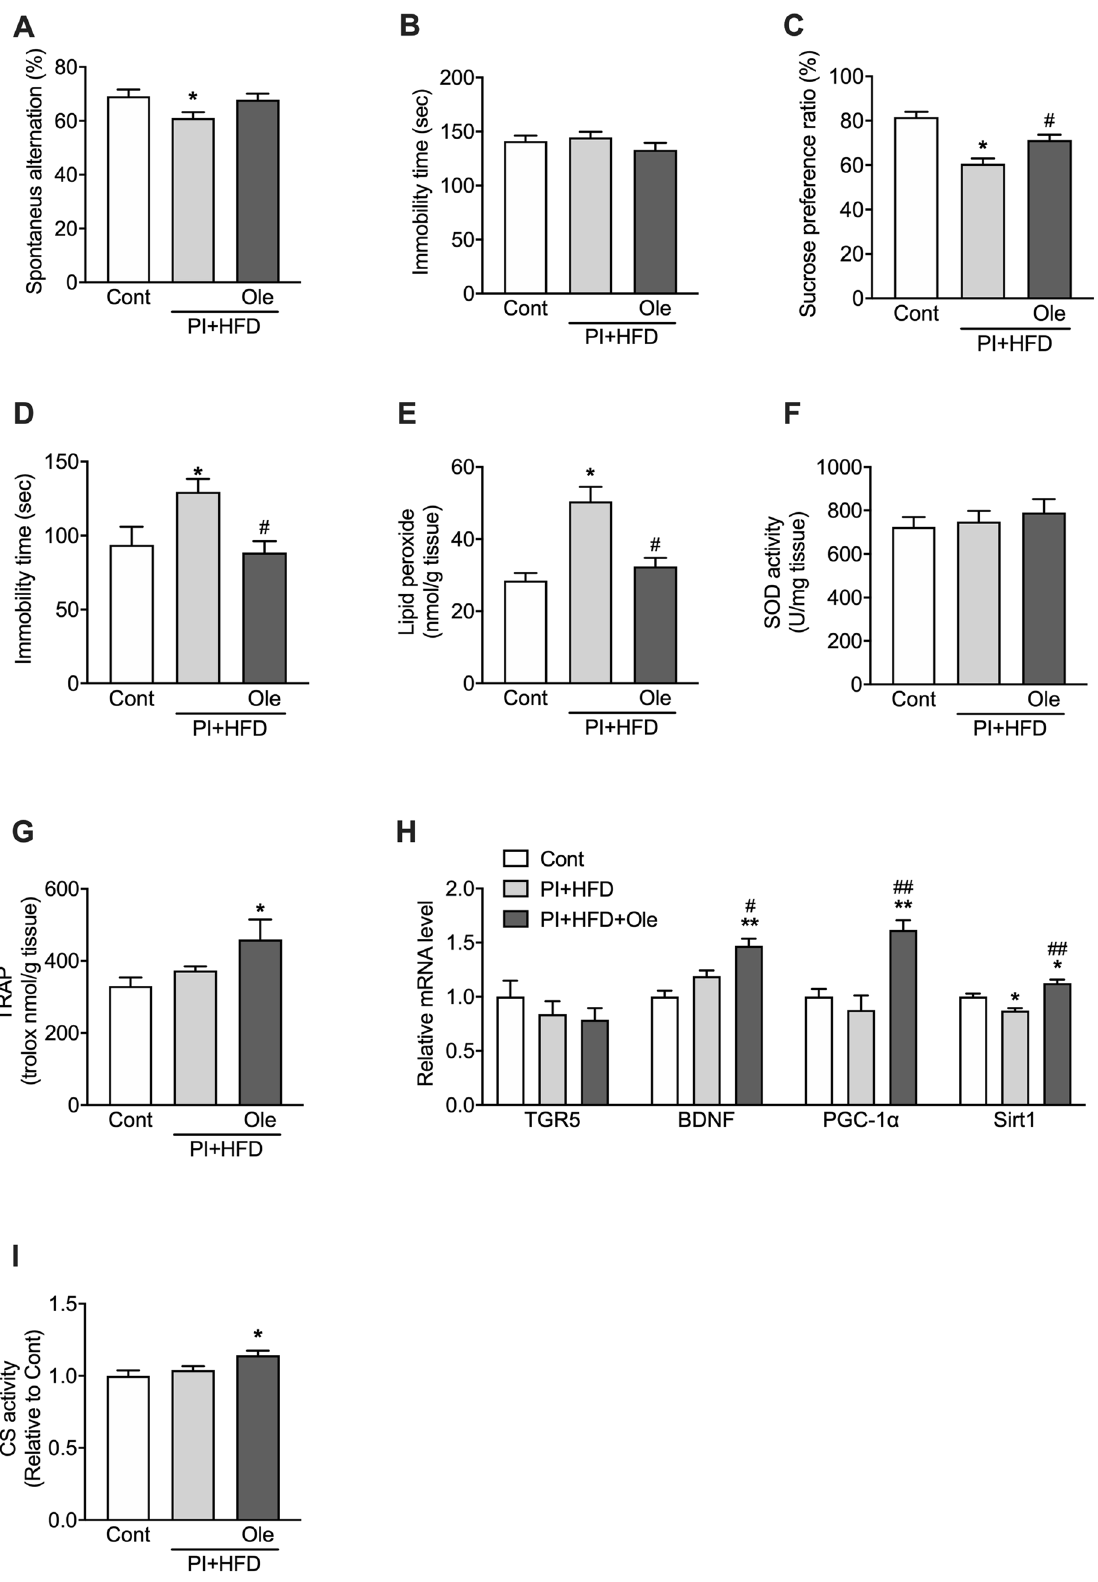
Figure 2. Olive leaf extract (Olea) prevented behavioral changes induced by inactivity and intake of a HFD. ( A ) Accuracy rate in the Y-maze test, ( B ) immobility time in the contextual fear conditioning test, ( C ) sucrose preference ratio in the sucrose preference test, ( D ) immobility time in the forced swim test, ( E ) hippocampal lipid peroxide content, ( F ) hippocampal SOD activity, ( G ) hippocampal TRAP level, ( H ) mRNA expression levels of TGR5 , BDNF , PGC-1α , and Sirt1 in the hippocampus by real-time polymerase chain reaction analysis, and ( I ) CS activity in the hippocampus. Data are expressed as mean ± SEM. *p < 0.05 vs control, # p < 0.05 vs PI + HFD as determined by one-way